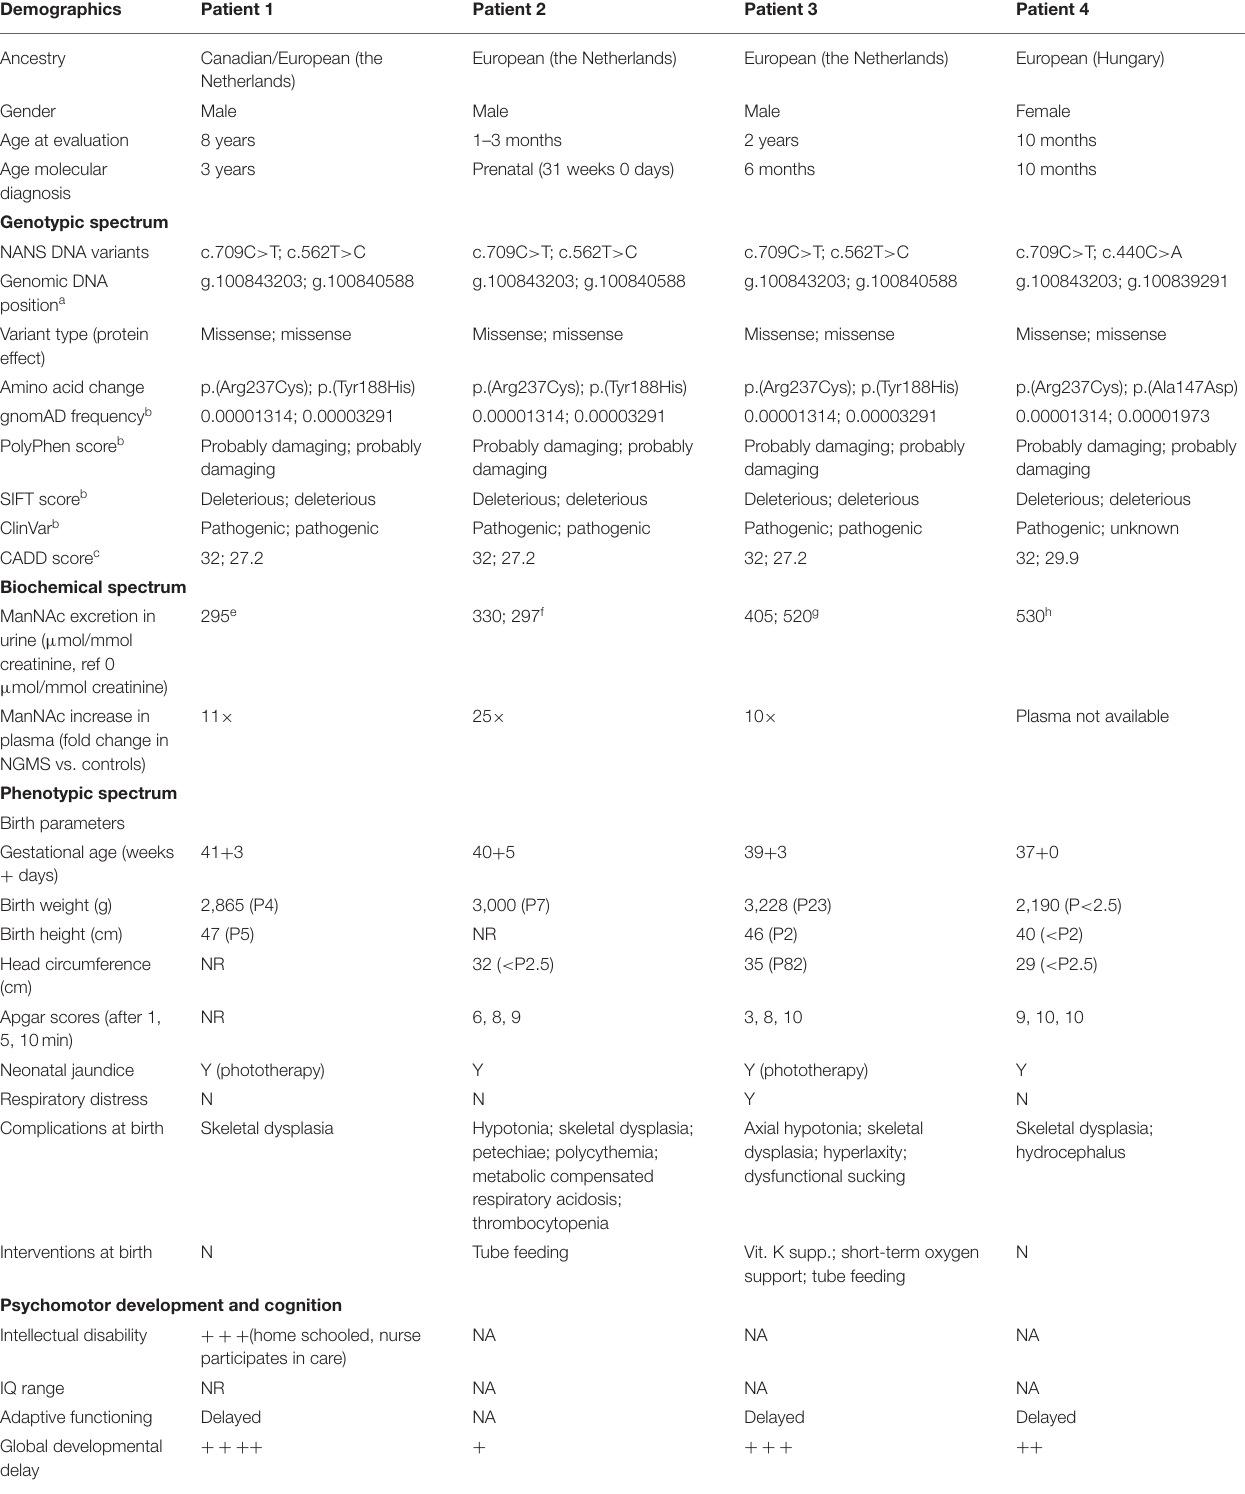
TABLE 1 | Overview of demographic, genomic, biochemical, and clinical data of nine patients with NANS-CDG.